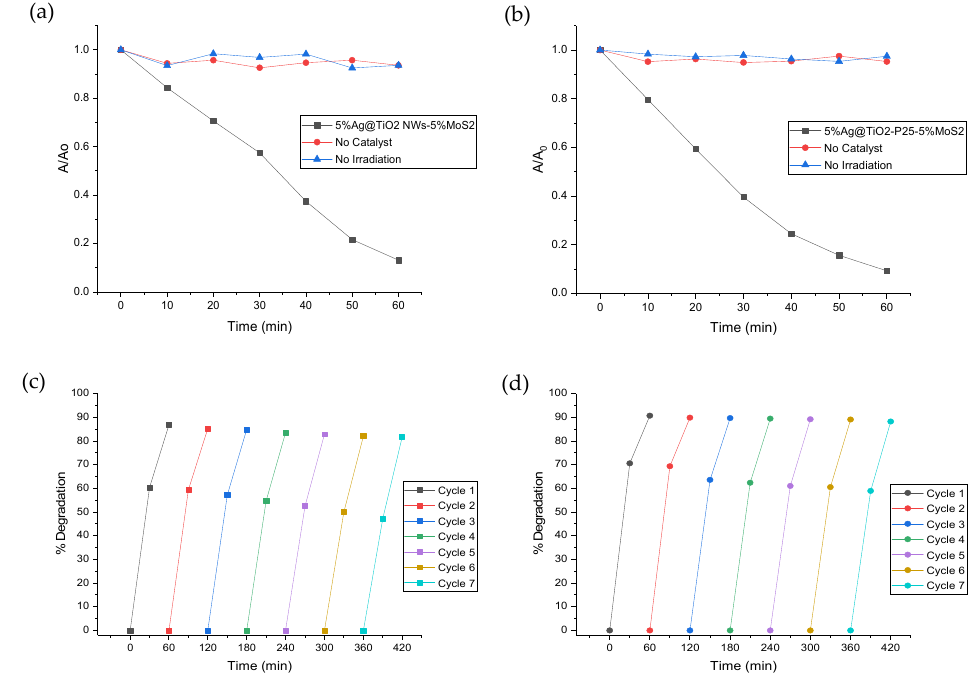
Figure 8. Control experiments and stability tests for 5%Ag@TiO 2 NWs-5%MoS 2 ( a , c ), and 5%Ag@TiO 2 -P25-5%MoS 2 ( b , d )